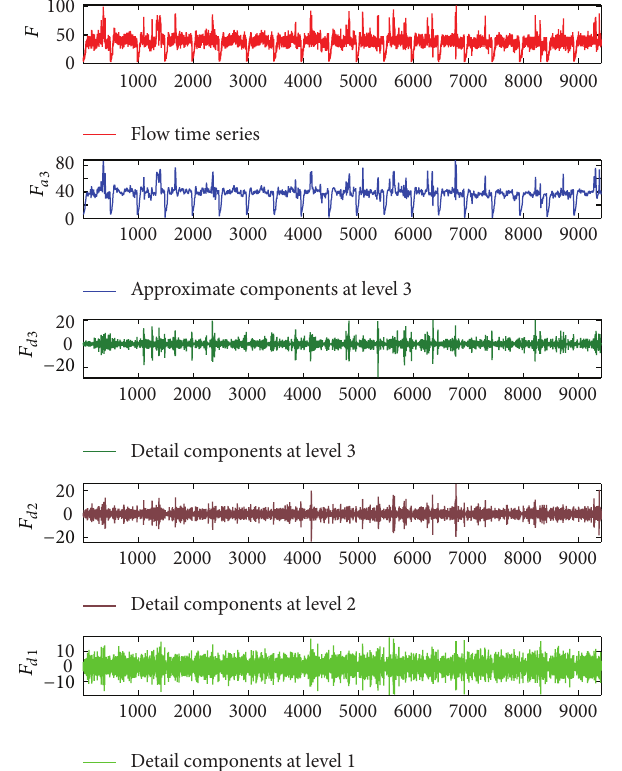
Figure 3: Flow time series wavelet decomposition at the 15th detector. Self-similarity is present at each decomposition level in wavelet decomposition diagrams on flow. Symbols qualitatively show the chaos existence in flow time